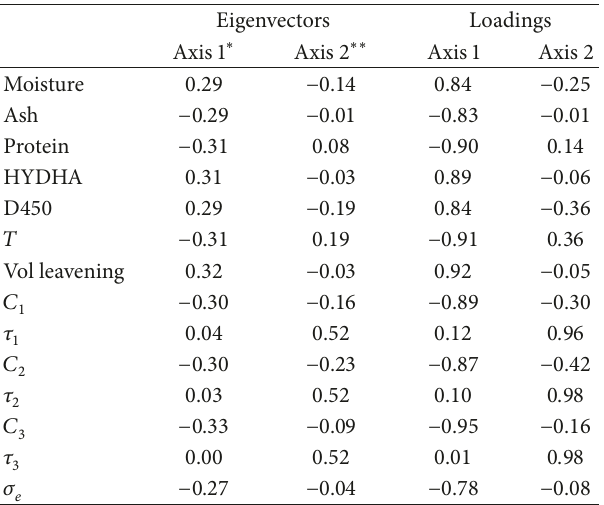
Table 2: Proportion of total variation and eigenvectors of principal component (PC) axes in a principal component analysis performed on all the traits